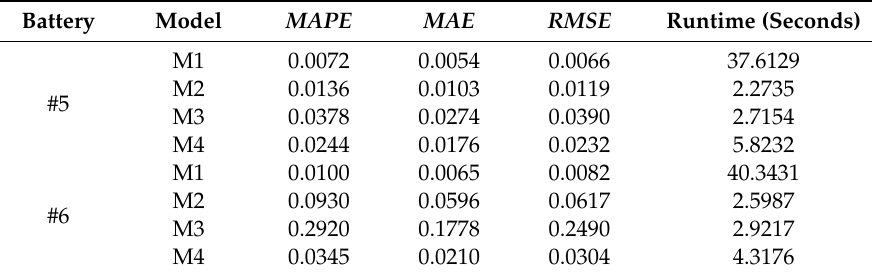
Table 2. Comparison of four models (M1–M4) for two batteries.